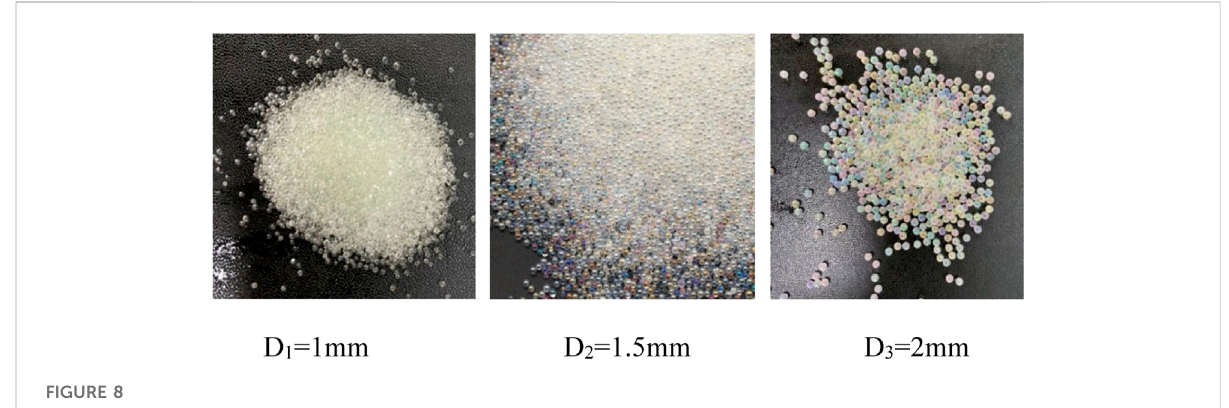
FIGURE 8 Insoluble particle diameter